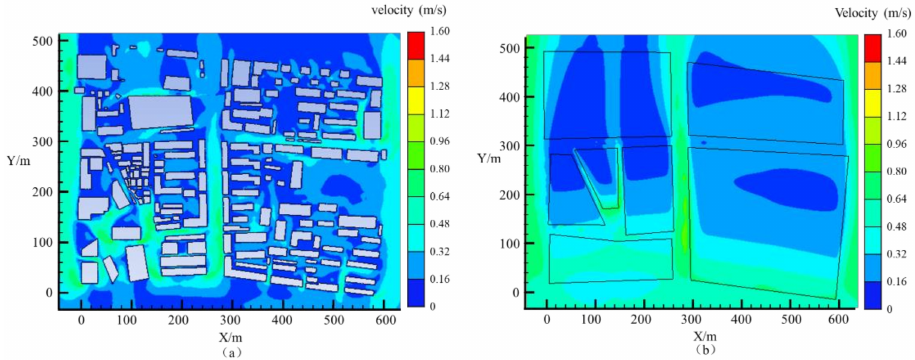
Figure 10. Diagram of wind velocity distribution modeled by the ( a ) standard CFD method and ( b ) porous media method.